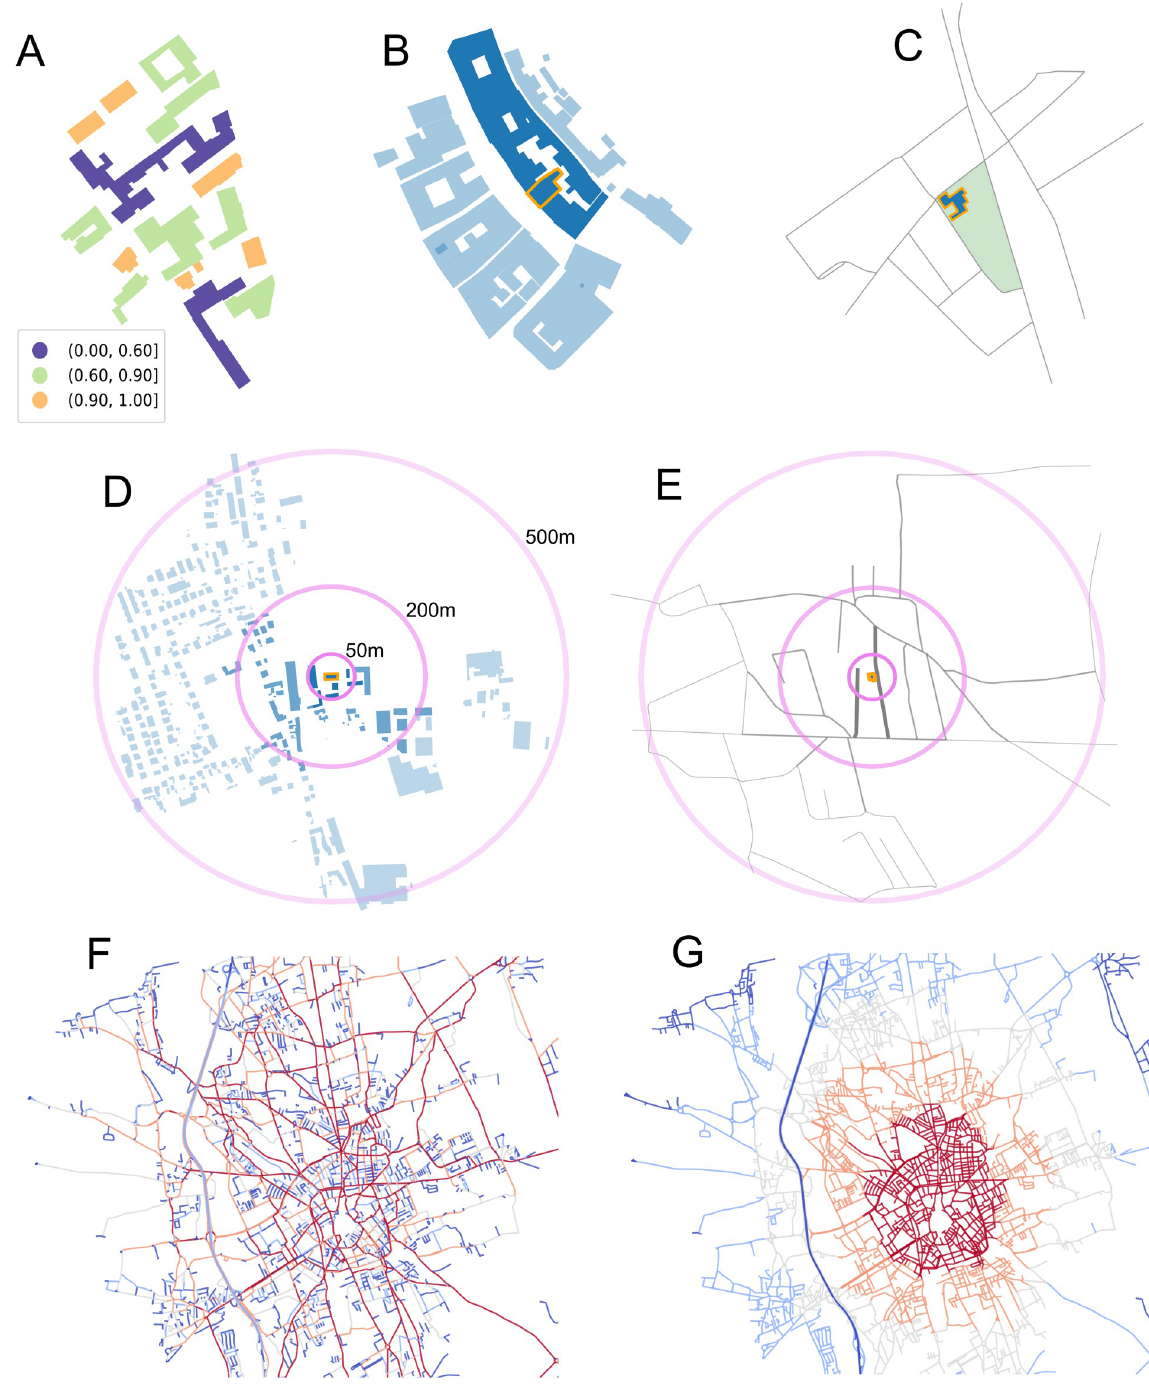
Fig 2. Illustrations of the urban form features used. (A) Individual building footprint geometries. The convexity values of buildings’ footprint polygon are displayed in the legend. Convexity ranges between 0 and 1. (B) Block of adjacent buildings. The block in which a building of interest is located is depicted in dark blue. (C) Street-based block, in green, surrounding a building of interest. (D) Buildings within a circular buffer of 50, 200 and 500 m around a building of interest. (E) Streets within a circular buffer of 50, 200 and 500 m around a building of interest. (F) Betweeness centrality shows main streets and secondary streets. We use as features for example the betweeness centrality of the closest street, or the average within a buffer. (G) Closeness centrality shows where streets are converging. Both centrality measures give information on the structure of the city and relative position of a street in the city street